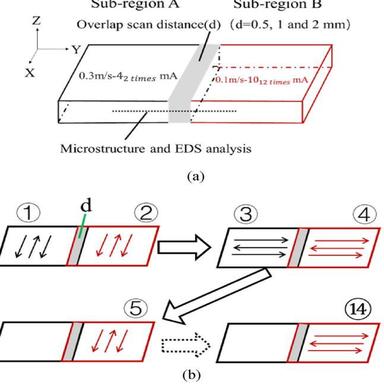
Schematic representation of the fabrication of the functionally graded materials with graded composition:(a) Schematic representation of the fabrication process of the 1D FGMs; (b) The scan path of multiple-scan strategy with a layer.